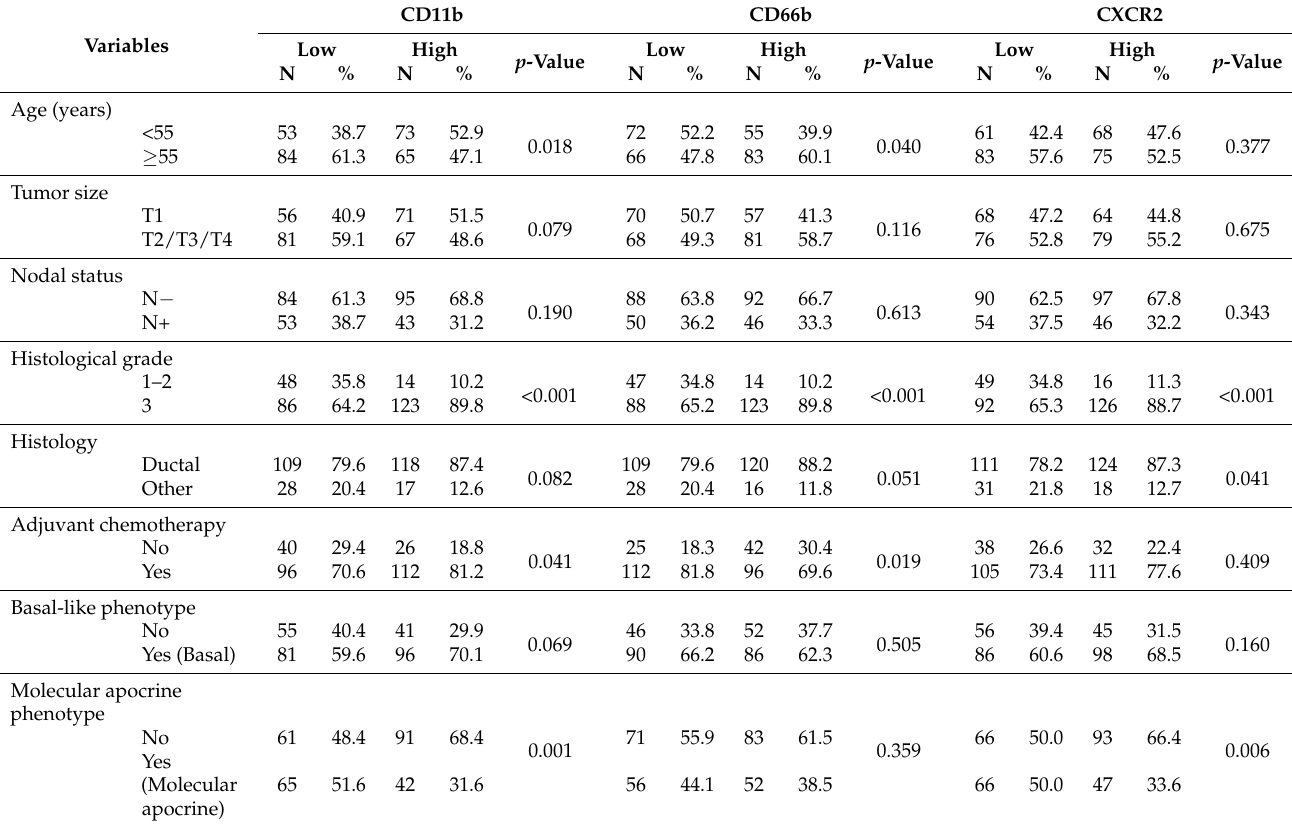
Table 2. Correlations of CD11b, CD66b and CXCR2 expression with clinicopathological